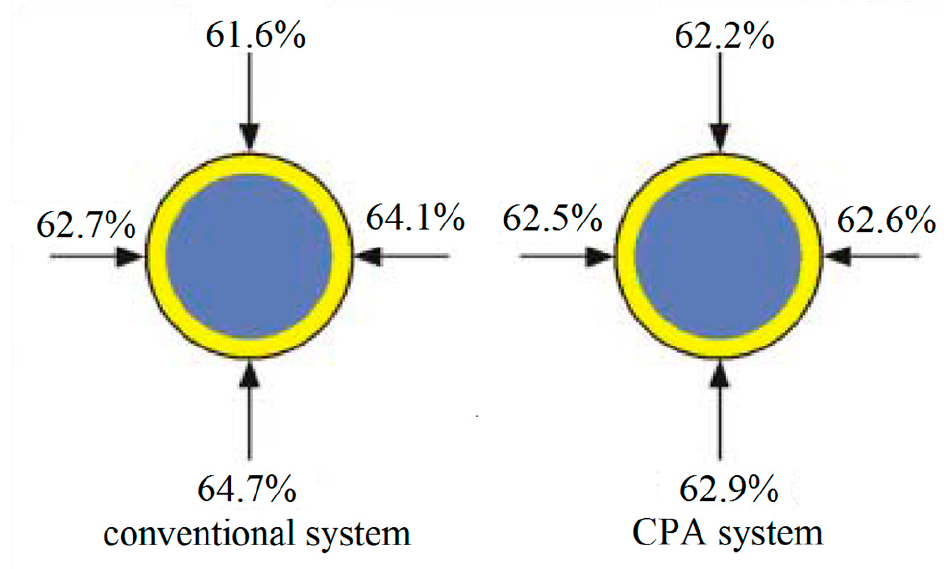
Figure 19. Schematic diagram of the tire strap layer made of a steel cord [28].